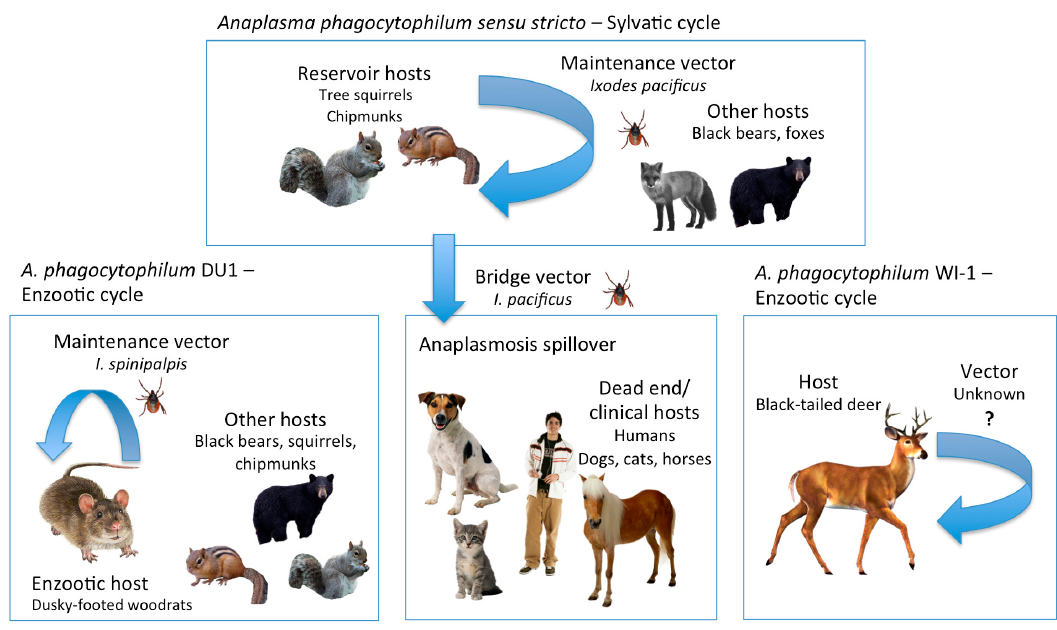
Figure 1. Proposed epidemiological cycles of the Anaplasma phagocytophilum sensu lato complex in California.